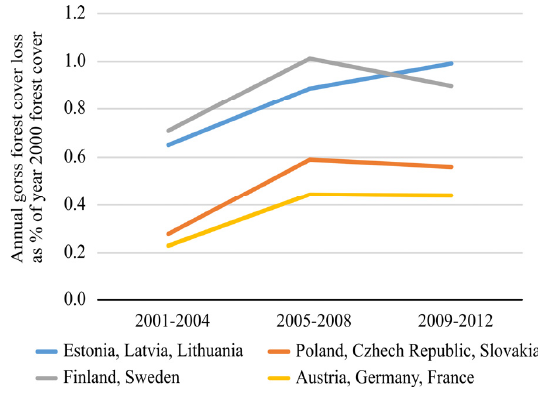
Figure 3. Annual gross forest cover loss (4-years average) as percent of year 2000 forest cover for groups of selected countries. Data from Hansen et al., 2013, downloaded from